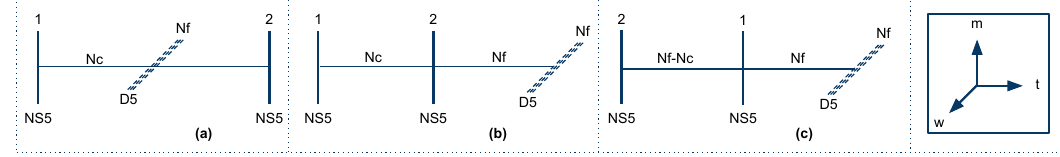
Figure 1 . Brane manipulations in type IIB string theory which yield a naive dual. Solid vertical lines are NS5 branes. Horizontal lines are coincident D3 branes. Dashed lines are D5 branes. The legend indicates the compacti(cid:12)cation direction (t or x 6 ) and the directions of possible triplet mass (m) terms (3,4,5), and possible triplet FI (w) terms (7 8 9). Directions (0 1 2) are common to the world volume of all branes and are suppressed. We (cid:12)rst move N f D5 branes through the right NS5 brane, creating N f D3 branes in the process. We then exchange the two NS5 branes, changing the number of suspended D3 branes in the